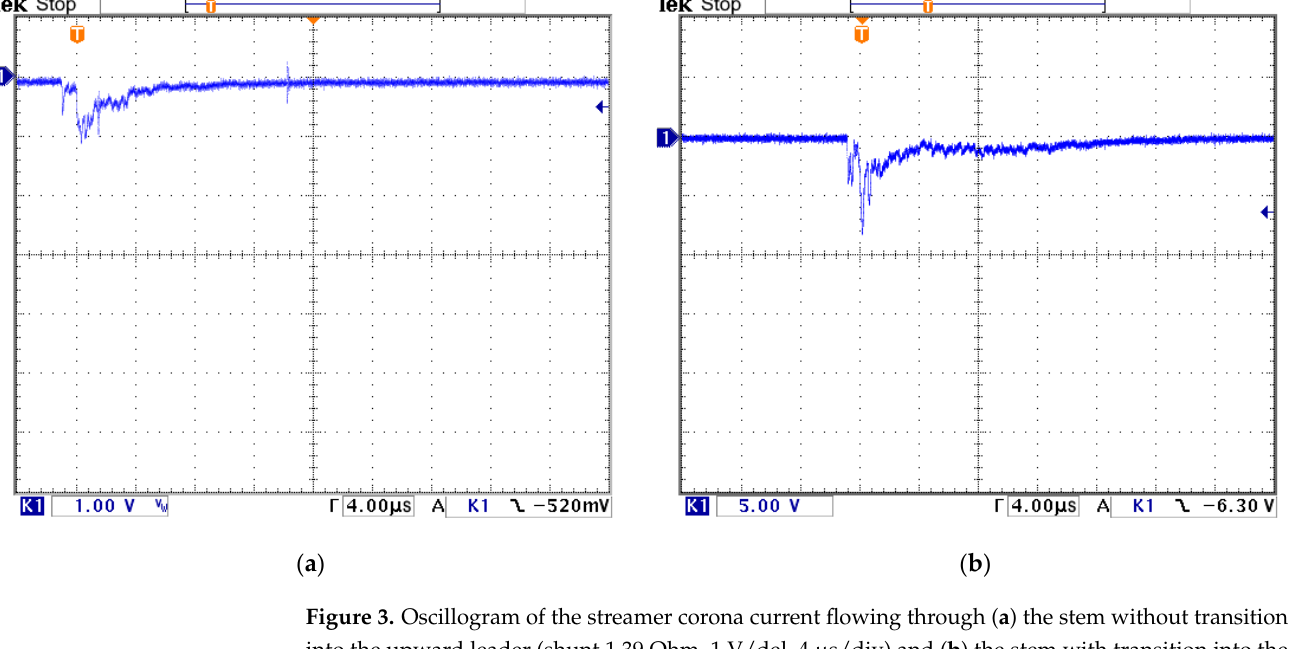
Figure 4. Streamer corona flash ( a ) without upward leader transition (frame duration 3.5 µs, pause between frames 0.1 µs, frame size 0.75 × 0.75 m) and ( b ) with upward leader transition (frame du- ration 2.5 µs, pause between frames 0.1 µs, frame size 0.75 × 0.75 m).